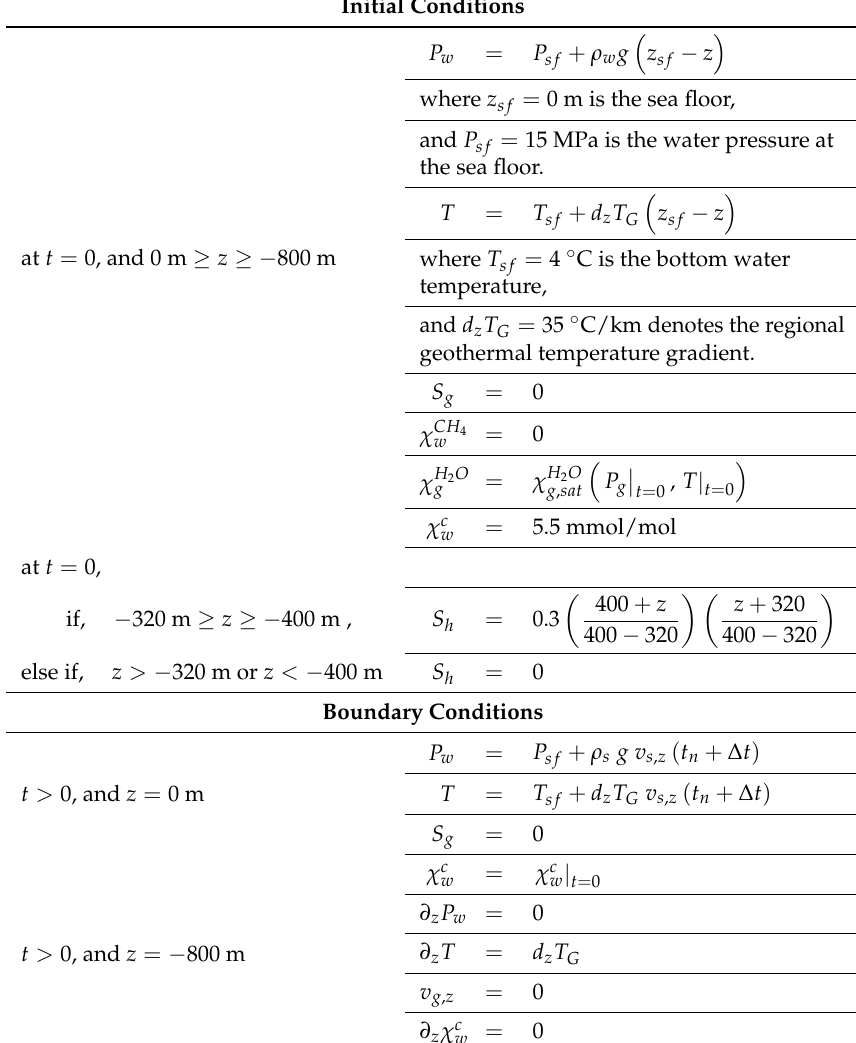
Table 1. Initial and bounday conditions for Example 1 (Section